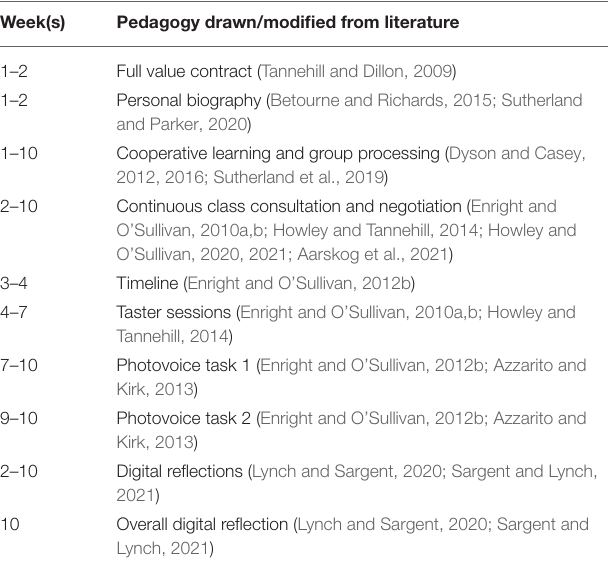
TABLE 2 | Enacted pedagogies drawn from literature and research prioritizing student voice.